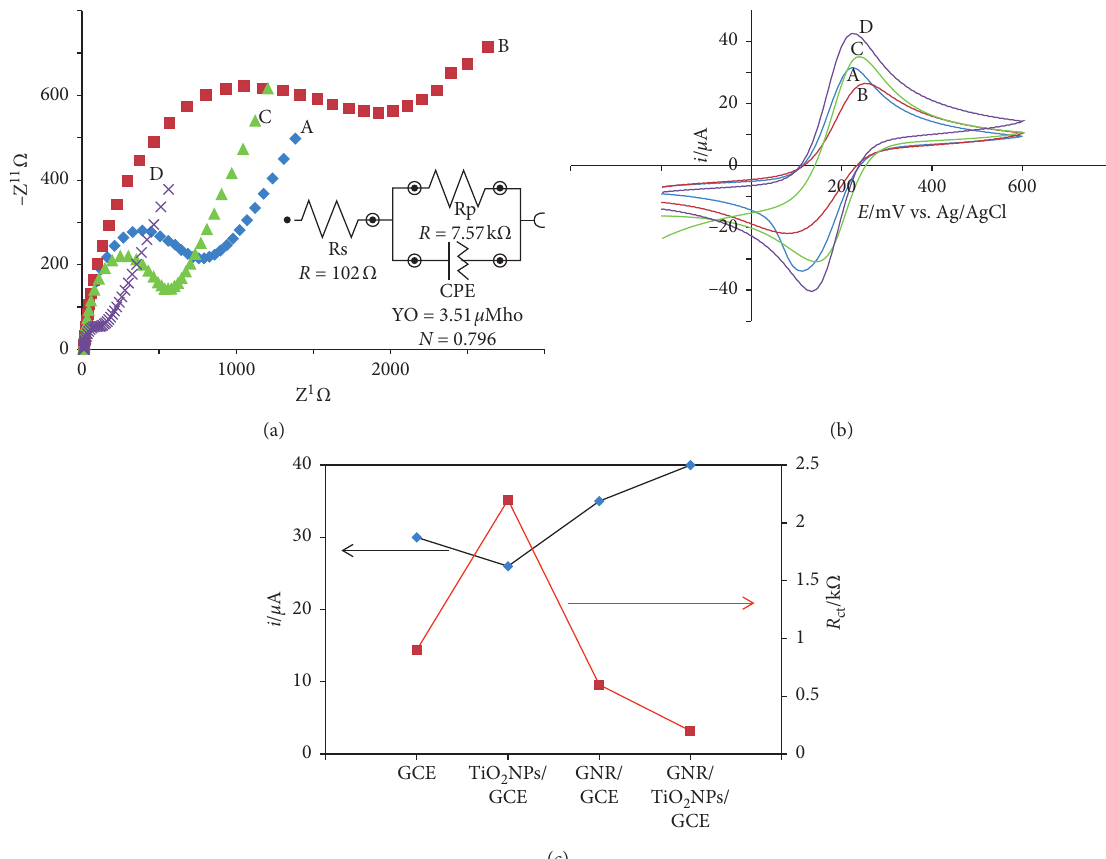
Figure 2: (a) EIS behavior of modified GCE in the presence of 1mM [Fe(CN) presence of 1 mM [Fe(CN) 6 ] 3 − /4 − in 0.1M KCl at a scan rate of 100mVs − 1 . (c) Plot of i pa and R et versus modified GCEs; (a) GCE, (b) TiO 2 / GCE, (c) GNR/GCE, and (d) TiO 2 /GNR/GCE.